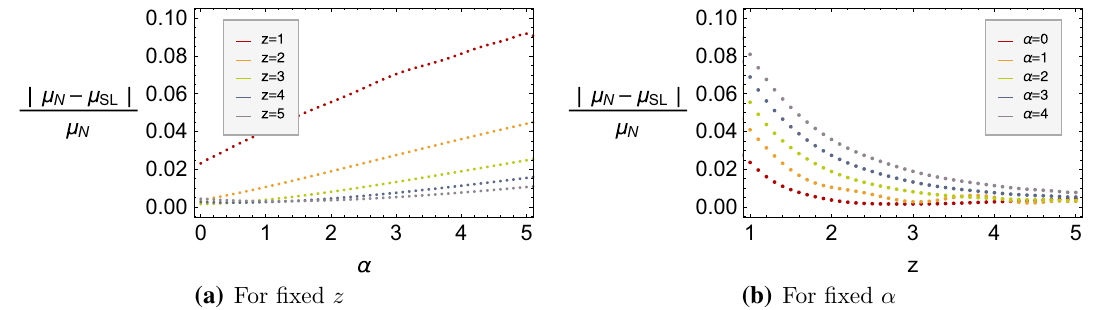
Fig. 1 Plot for the chemical potential μ versus α (or z ) for the given values of z (or α ). The solid lines show graphs of the upper bounds obtained from the analytic methods and the dashed lines present the numerical results